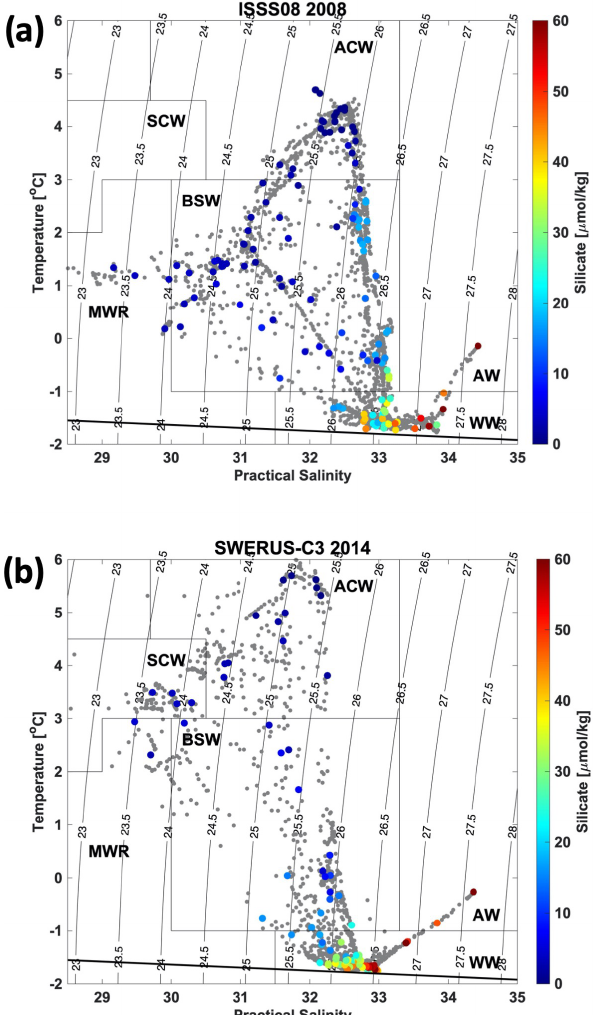
Figure 3. Temperature–salinity diagrams for sections 1–4 in Her- ald Canyon (section locations shown in Fig. 1b) for (a) 2008 and (b) 2014. Grey dots are the CTD data at 1dB depth resolu- tion; coloured dots are from the bottle data colour coded by sili- cate concentration. Water masses are defined following Linders et al. (2017): WW is Pacific Winter Water (this is a combination of remnant winter water and newly ventilated winter water shown in Linders et al., 2017), MWR is meltwater/runoff, BSW is Bering Summer Water, AW is Atlantic Water, SCW is Siberian Coastal Wa- ter, and ACW is Alaskan Coastal Water. The bold black line marks the surface freezing